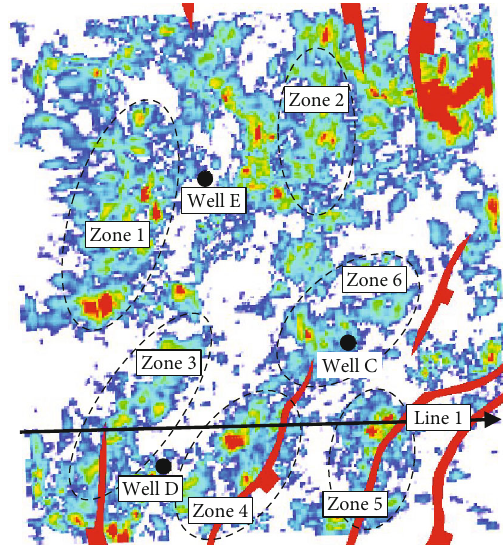
Figure 8: RMS attribution of the di ff racted wave of RMS prediction map of igneous